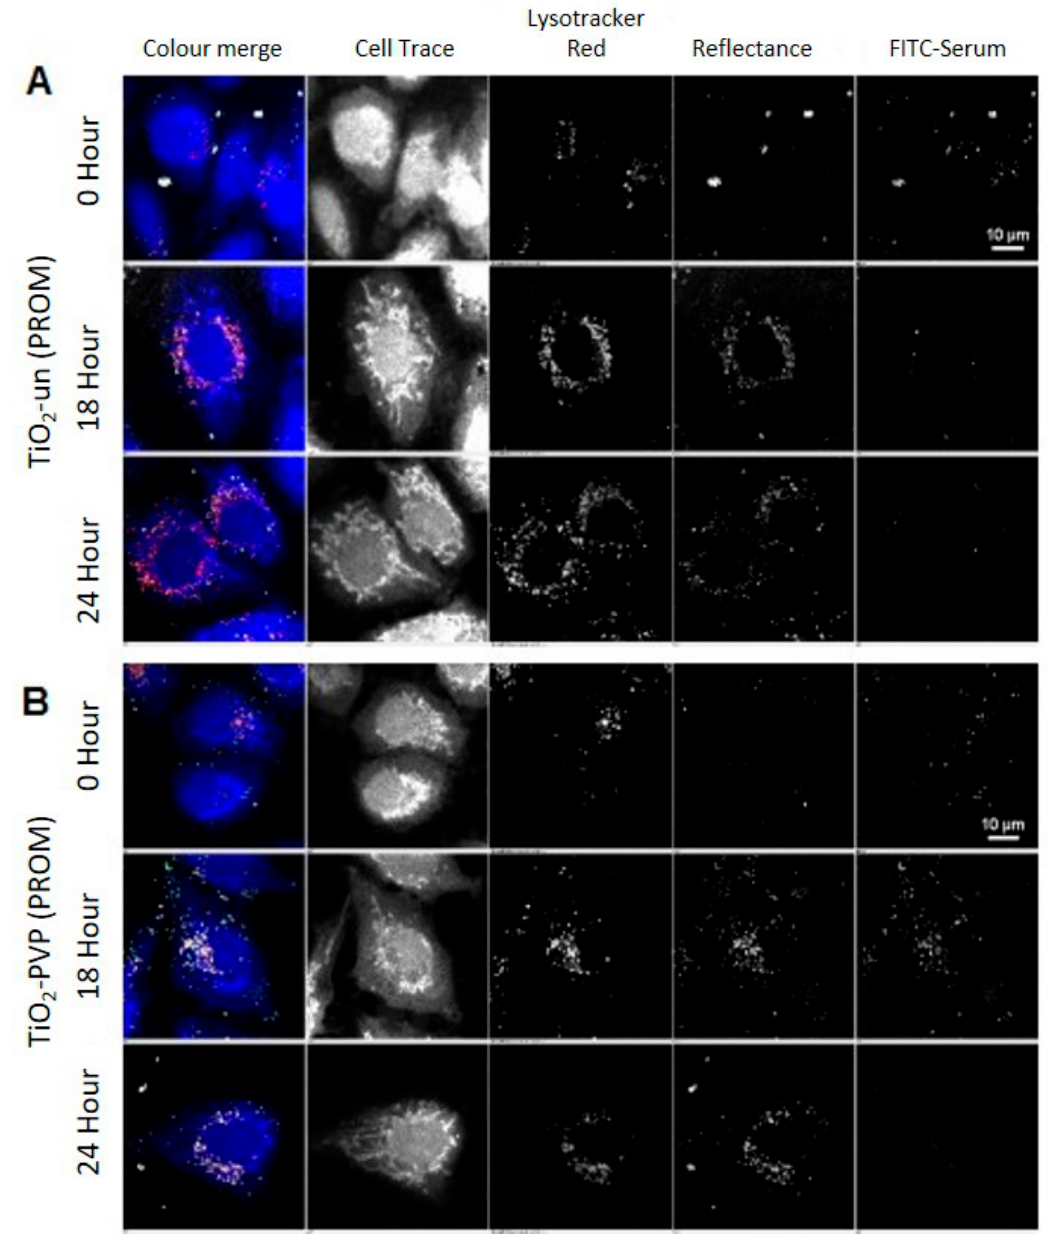
Figure 3. Confocal acquisition of A549 cells treated with uncoated (TiO 2 -un) and PVP-coated (TiO 2 -PVP) TiO 2 NMs compared to the control (untreated cells) in FITC-labeled serum, followed by post-acquisition in unlabeled serum and fixation at 15 min (0 h), 2, 6, 18, and 24 h post-exposure. ( A ) Images show the presence of TiO 2 -un as large, bright agglomerates associated with the surface of the cell, which are subsequently internalized and trafficked to lysosomes marked by lysotracker red. Past the 0 h time point, TiO 2 -un rapidly loses the FITC signal, suggesting that in the absence of a surface coating, the protein corona is not stably bound. ( B ) TiO 2 -PVP, on the other hand, demonstrates an increase of the FITC signal up to the 18 h time point, after which there is a significant loss of signal. As NMs co-localize well with lysotracker at 18 and 24 h, this is likely due to degradation of the protein corona within the acidic lysosomal compartment.